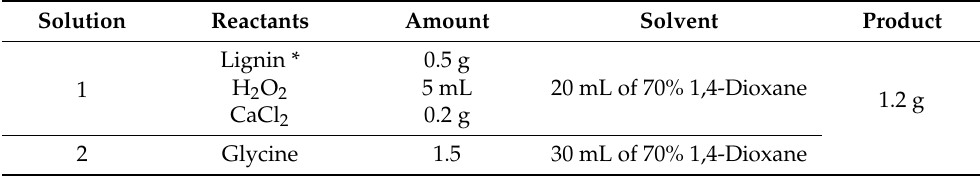
Table 2. Relevant data on lignin and glycine polymerization.